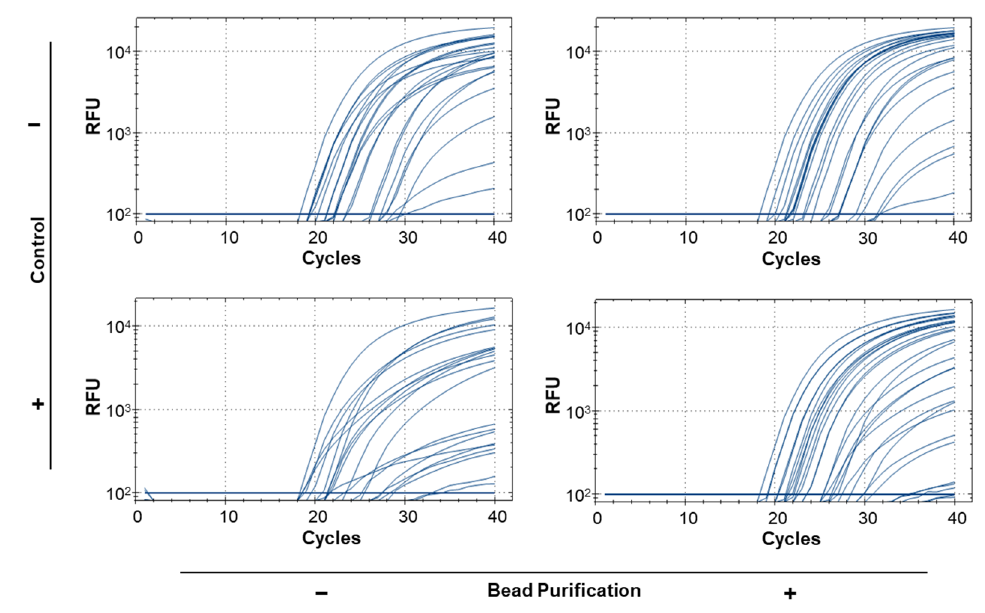
Figure 2. Real-time PCR reactions representing 59 samples of 1:50 ( H. armigera : H. zea ) legs. Samples were run 4 times: with and without bead purification and with and without the presence of the 18S control probe and primers.